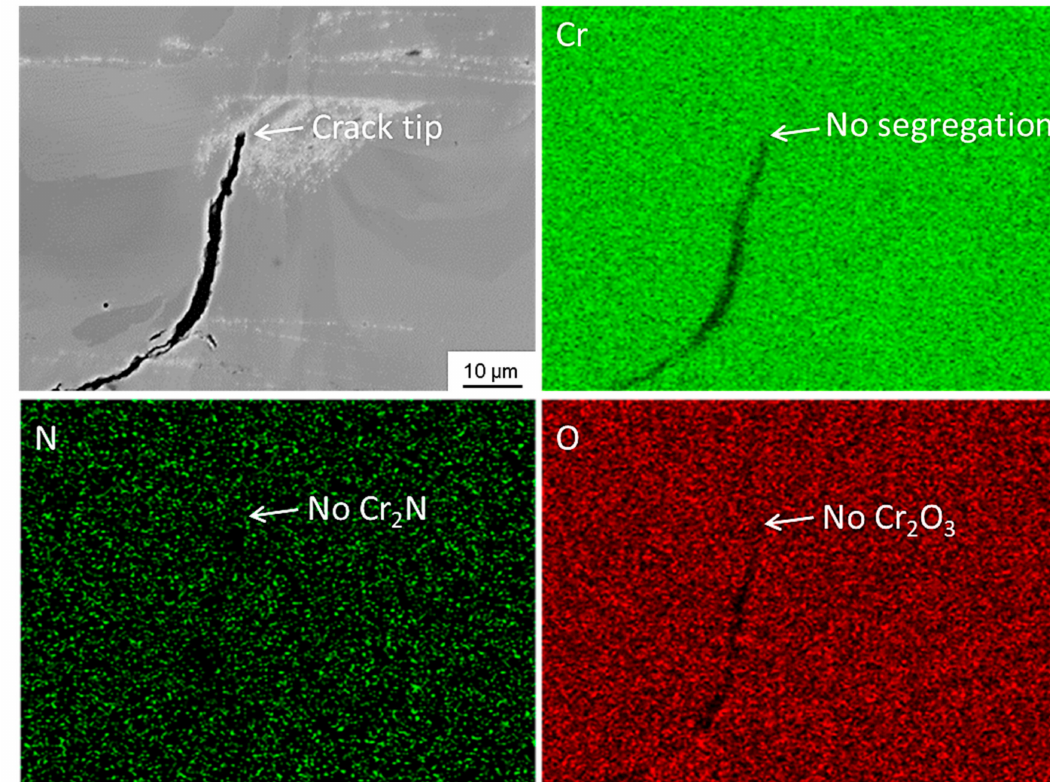
Figure 8. Energy dispersive X-ray spectroscope (EDS) map of as-built Cr components with long scan length (C10) exhibiting no segregation or impurity considering Cr, N, and O distribution.